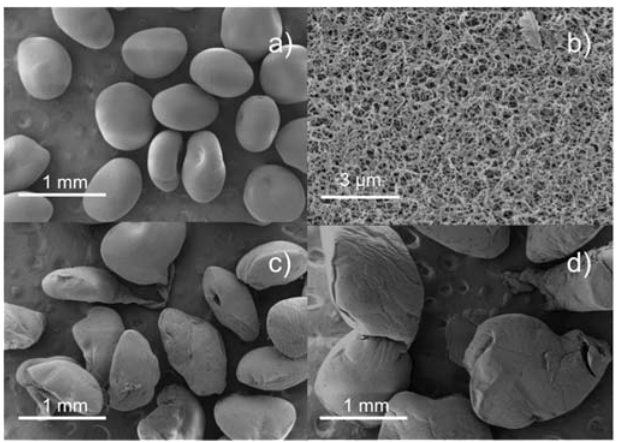
Figure 3. SEM images of chitosan aerogel particles processed with the nozzle diameter of 500 µ m at ( a , b ) 4000; ( c ) 6000; and ( d ) 2000 rpm.